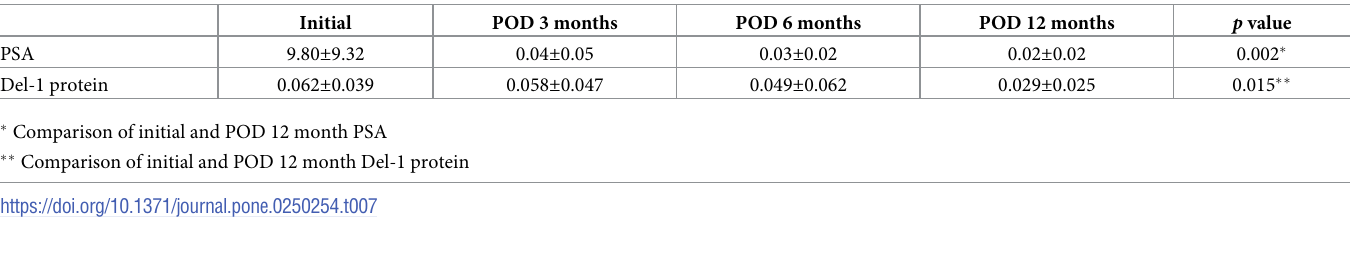
Table 7. Change of PSA and Del-1 protein in 14 patients who underwent radical prostatectomy and did not show biochemical